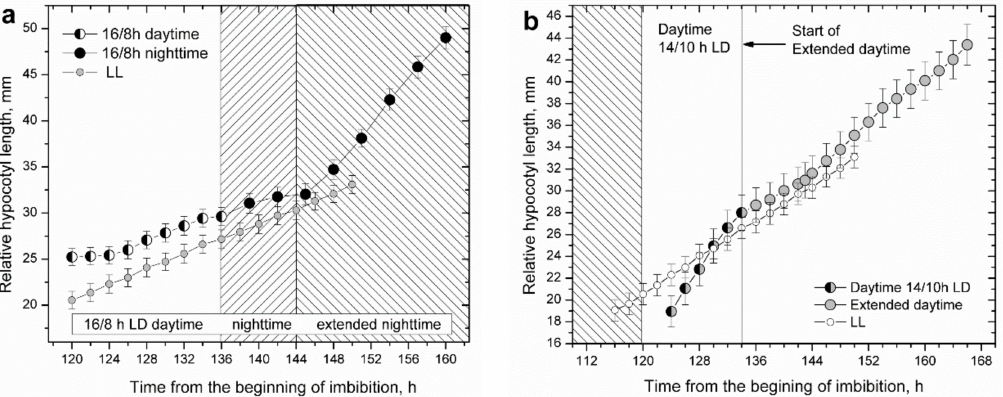
Figure 5. Rhythmic hypocotyl elongation of diurnal photoperiods rapidly changes to uniform (arrhythmic) elongation when the anticipated duration of the daytime or nighttime is breached. This happens when daytime or nighttime duration is extended. ( a ) Prolonged nighttime duration. At the expected end of nighttime, the lights were not turned on and there was no dawn. Shortly after the onset of extended darkness, hypocotyl elongation accelerated considerably and became uniform. ( b ) Prolonged daytime duration. At the expected end of daytime period, the light was not turned off and there was no dusk. In the extended daytime, elongation became uniform and the expected nighttime peak 1–2 h from dusk was absent. After the first 10 h of the prolonged daytime, which corresponds to the subjective night, hypocotyl elongation showed a small, transient increase. The extended daytime and nighttime durations both appeared as de novo start of free-running LL or DD